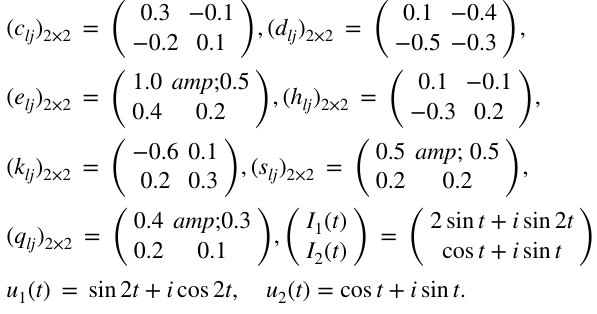
Fig. 1 Synchronization curves of x 1 and y 1